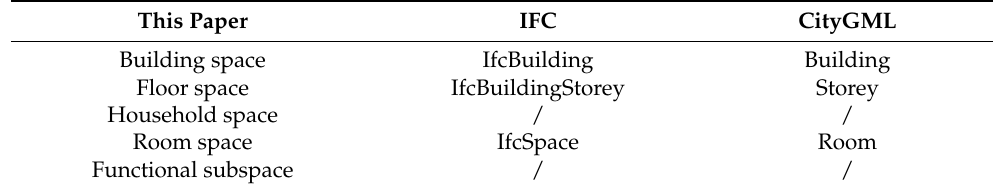
Table 6. Granularity comparison of indoor space models.